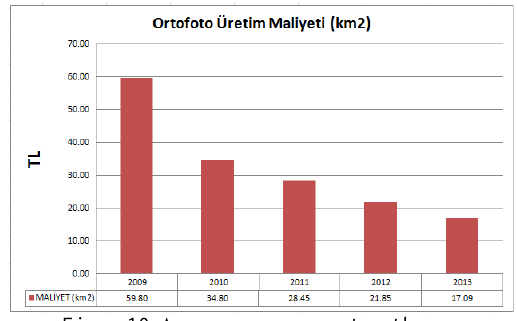
Figure 10. Average procurement cost by